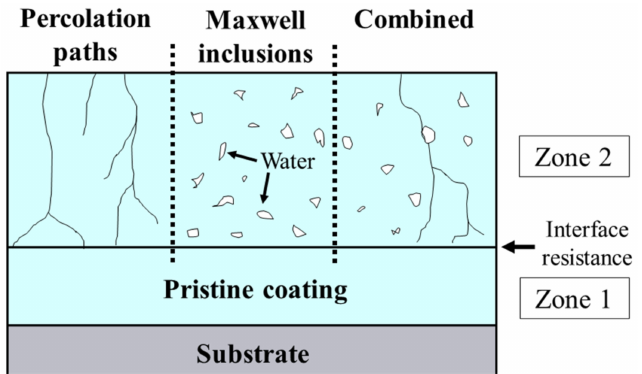
Figure 14. The electrical resistivity and relative dielectric constants for the diffusion-affected zone are modeled in three ways: first, as percolation paths which act as channels to deliver water to the interface and advance the diffusion-affected zone; the second model assumes a Maxwell-type two-phase system where water fills voids within the coating and coating inclusions; and the third model combines inclusions, holding most of the water, with a few channels that connect the water inclusions. Adapted from reference